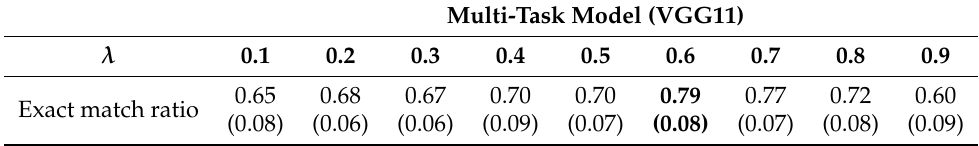
Table 3. Comparison of the hyperparameter λ for multi-task model. Comparisons of results using single-task models and multi-task models, in terms of exact match ratios. The best values for each architecture are in bold. The mean exact match ratio and standard deviations (in parentheses) are reported.